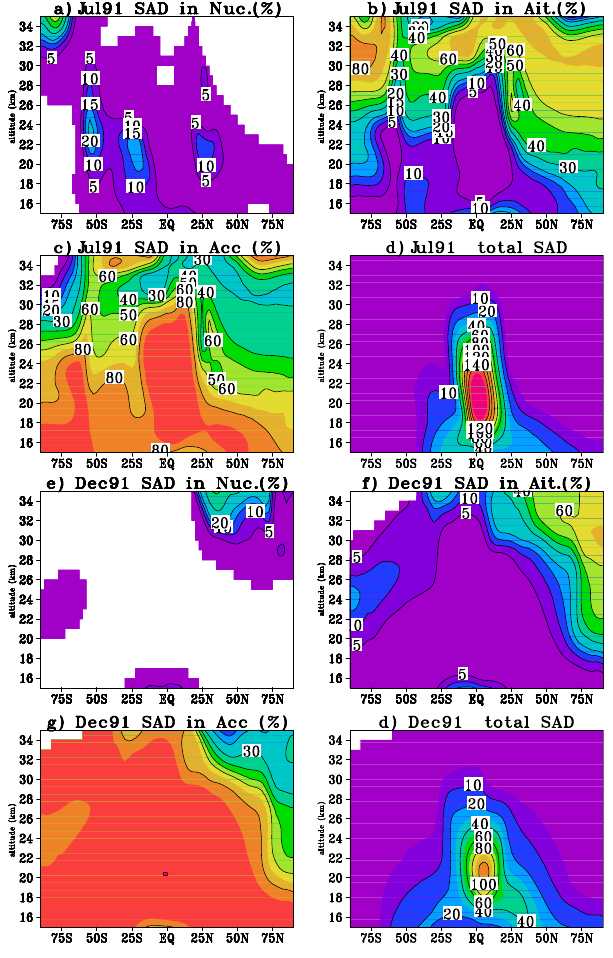
Figure 12. Percentage zonal mean surface area densities in nucle- ation, Aitken and accumulation modes from run A_Control20 for July 1991 (panels a, b, c ) and December 1991 (panels e, f, g ). Total SAD for July 1991 and December 1991 (µm 2 cm − 3 ) are shown in panels (d) and (h) , respectively.